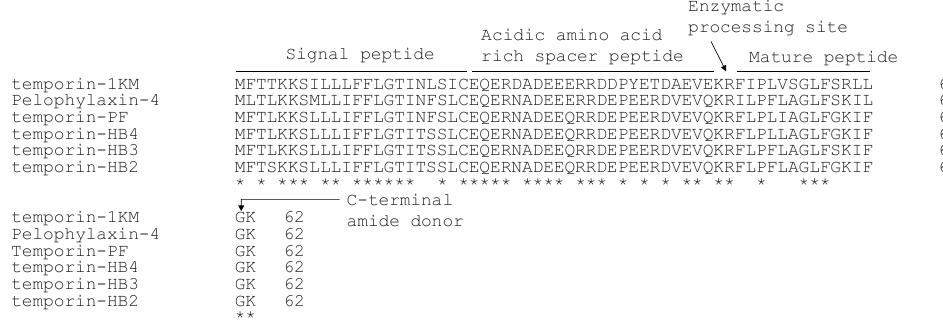
Figure 2. The alignment of translated open reading frame amino acid sequences of biosynthetic precursors. Temporin-1KM (accession No: AGE10577), Pelophylaxin-4 (accession No: Q2WCN5), and temporin-HB2,3,4 (accession No: AIU99904, AIU99906, AIU99905) were found in the skin secretion of Pelophylax nigromaculatus , Pelophylax fukienensis , and Pelophylax hubeiensis , respectively. The topological structure of precursors is indicated by a single line and arrows. The same amino acids of six peptides are marked with asterisks.